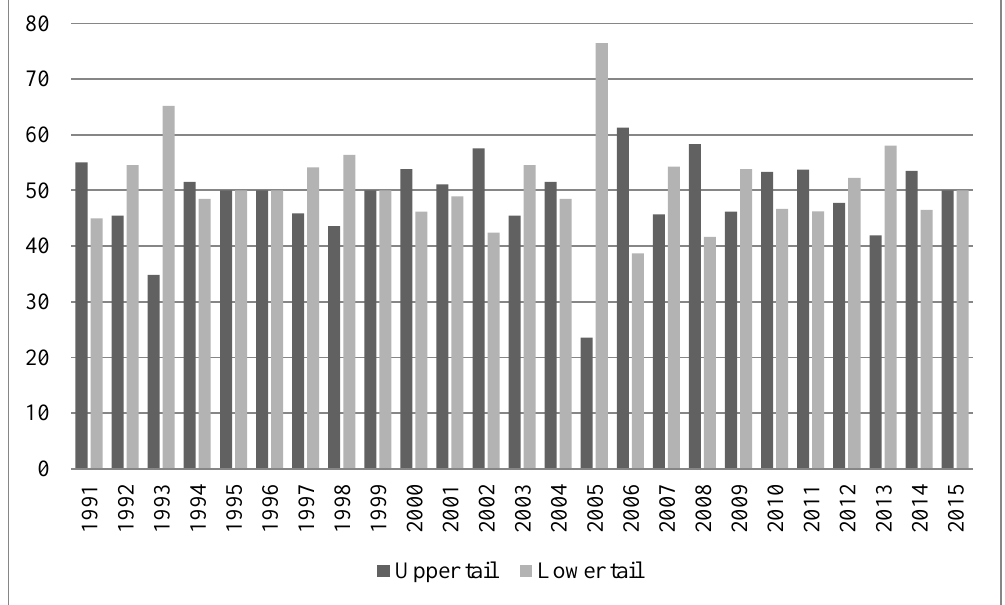
Fig. 2. Comparison of upper and lower tails on the Frankfurt Stock Exchange from 1991 to